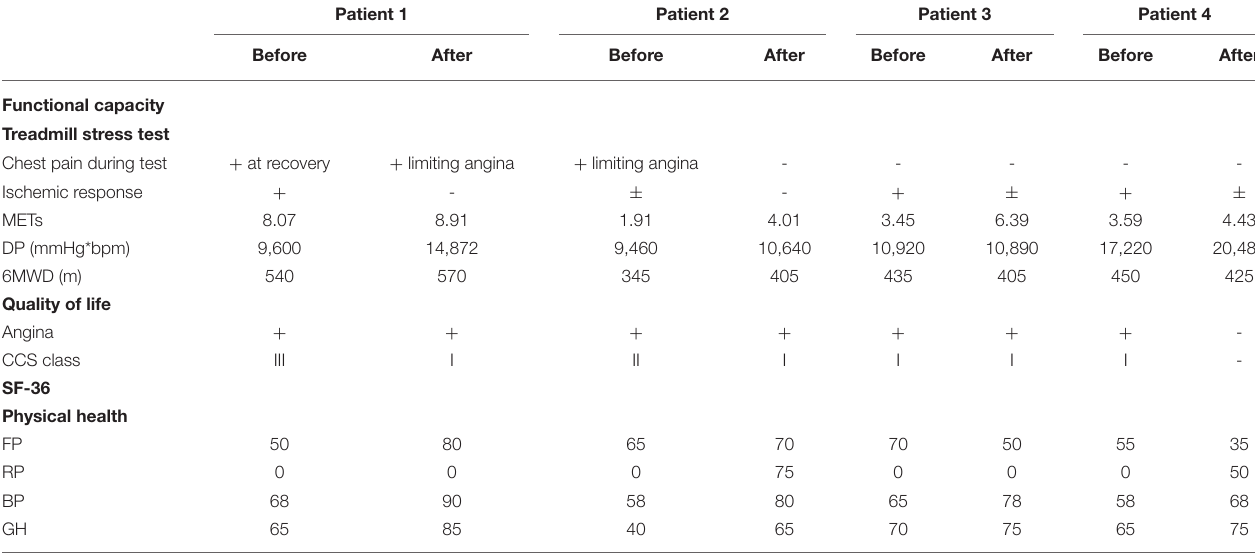
TABLE 3 | The effect of ESMR therapy to ischemic response, functional capacity, and quality of life. Patient